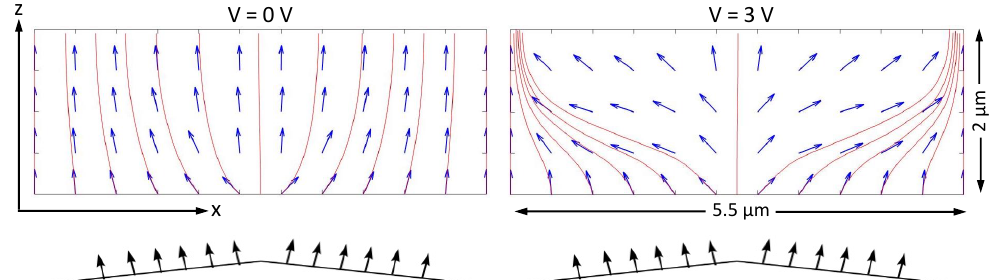
Figure 6. Director angle in a vertically aligned nematic (VAN) display with protrusions to produce opposite tilt directions in the two halves of the cell ( k 11 = 6.4 pN, k 33 = 10 pN, d = 2 µ m, ∆ χ = − 3). As explained in the text, the boundary conditions on the bottom substrate mimic a small protruding two-sided wedge with perpendicular anchoring, an example of which is illustrated just below the